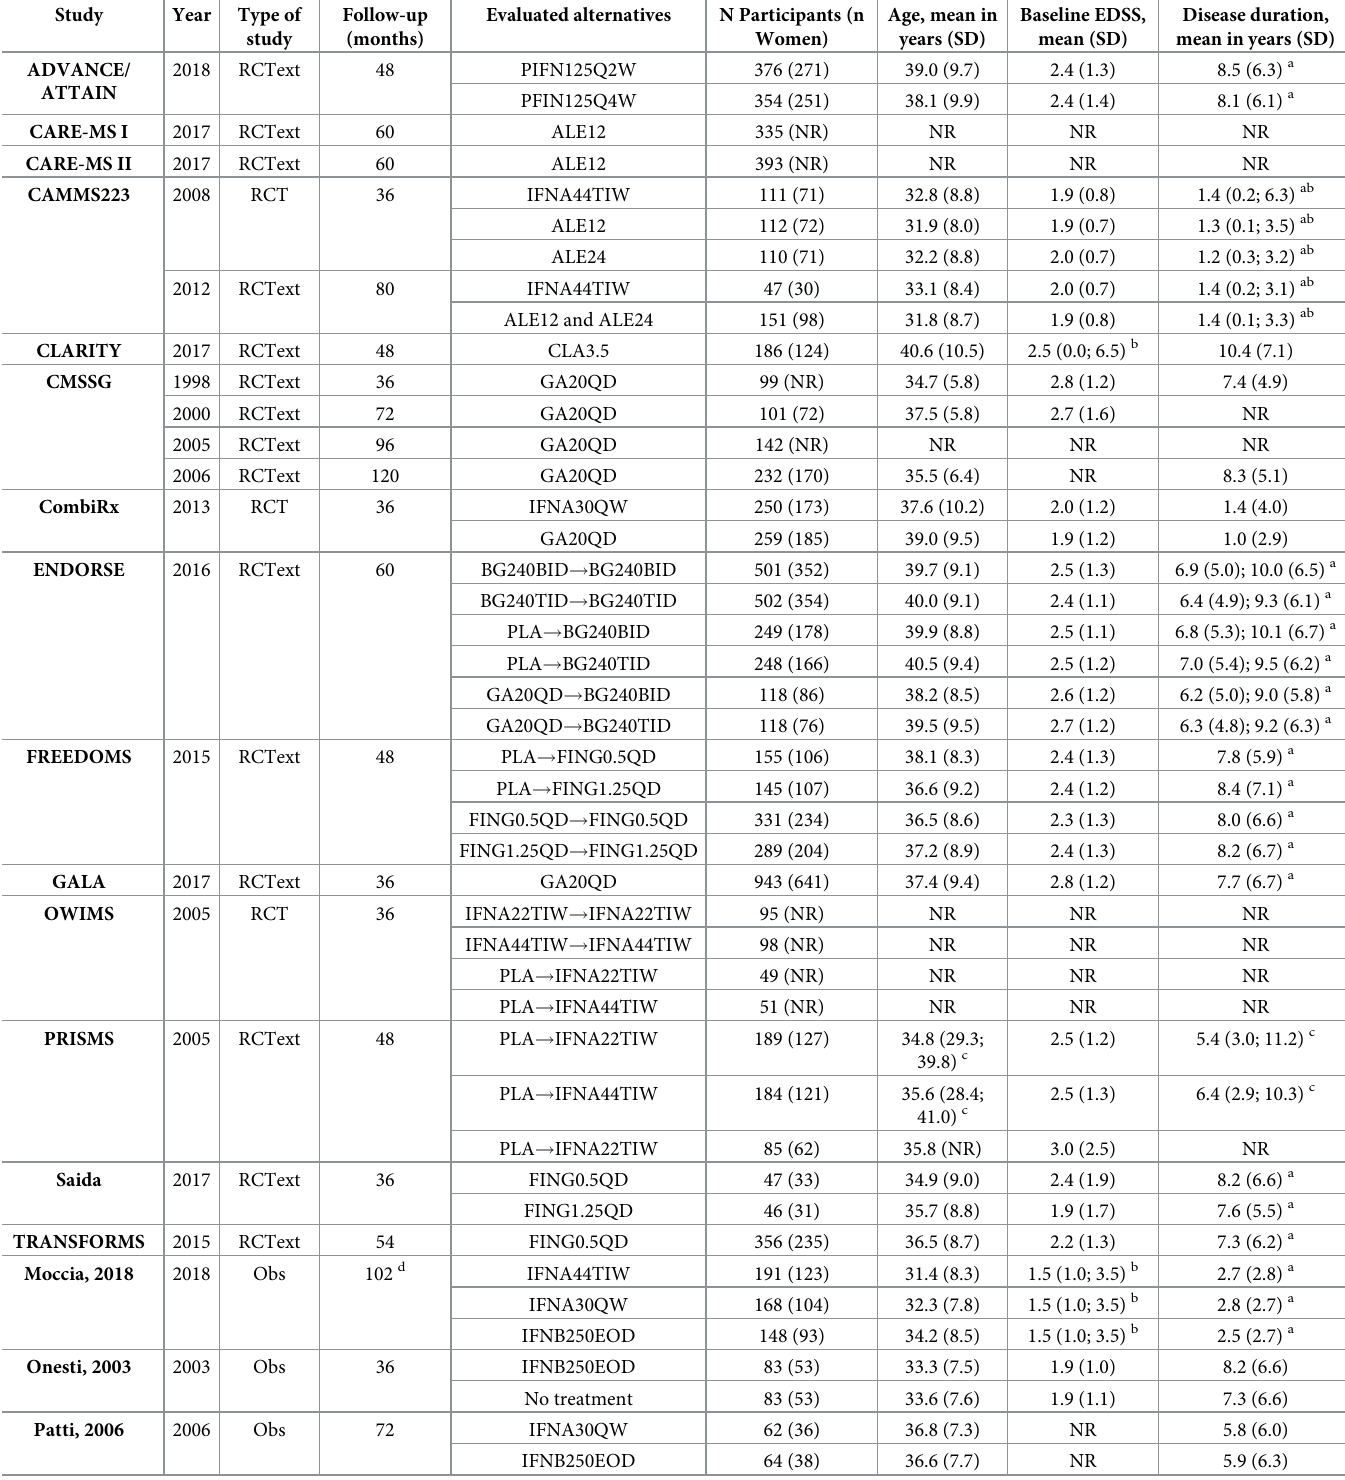
Table 1. Characteristics of the studies included in the systematic